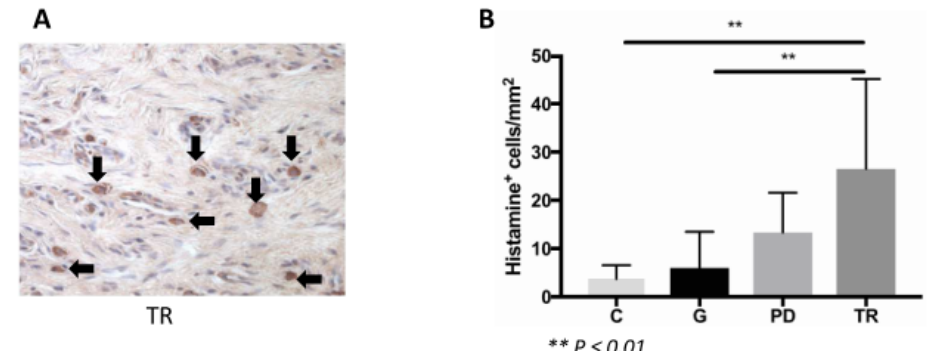
Figure 3. ( A ) Image of the immunohistochemical histamine staining in a TR section. The image was taken at 200 × magnification. MCs could be identified. ( B ) Immunohistochemical staining for histamine showed a significant increase of MCs in the TR group ( n = 11) compared with the control ( n = 7) and gingivitis groups ( n = 10) (both p ≤ 0.01). There was no difference between the TR and periodontitis groups ( n = 8).